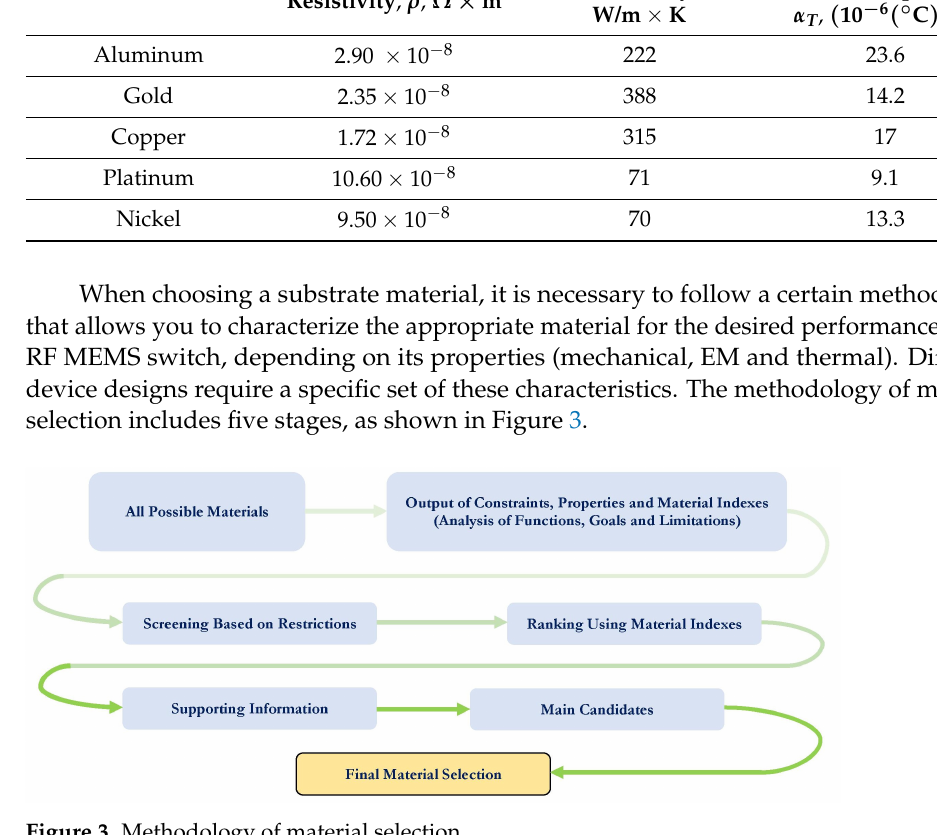
Figure 3. Methodology of material